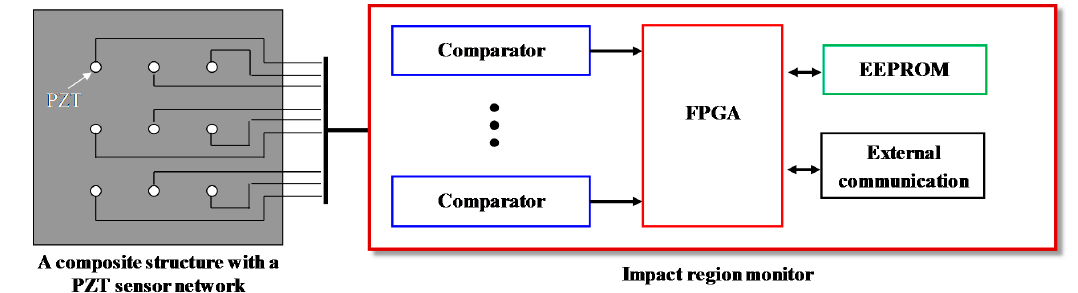
Figure 1. The architecture of the IRM.